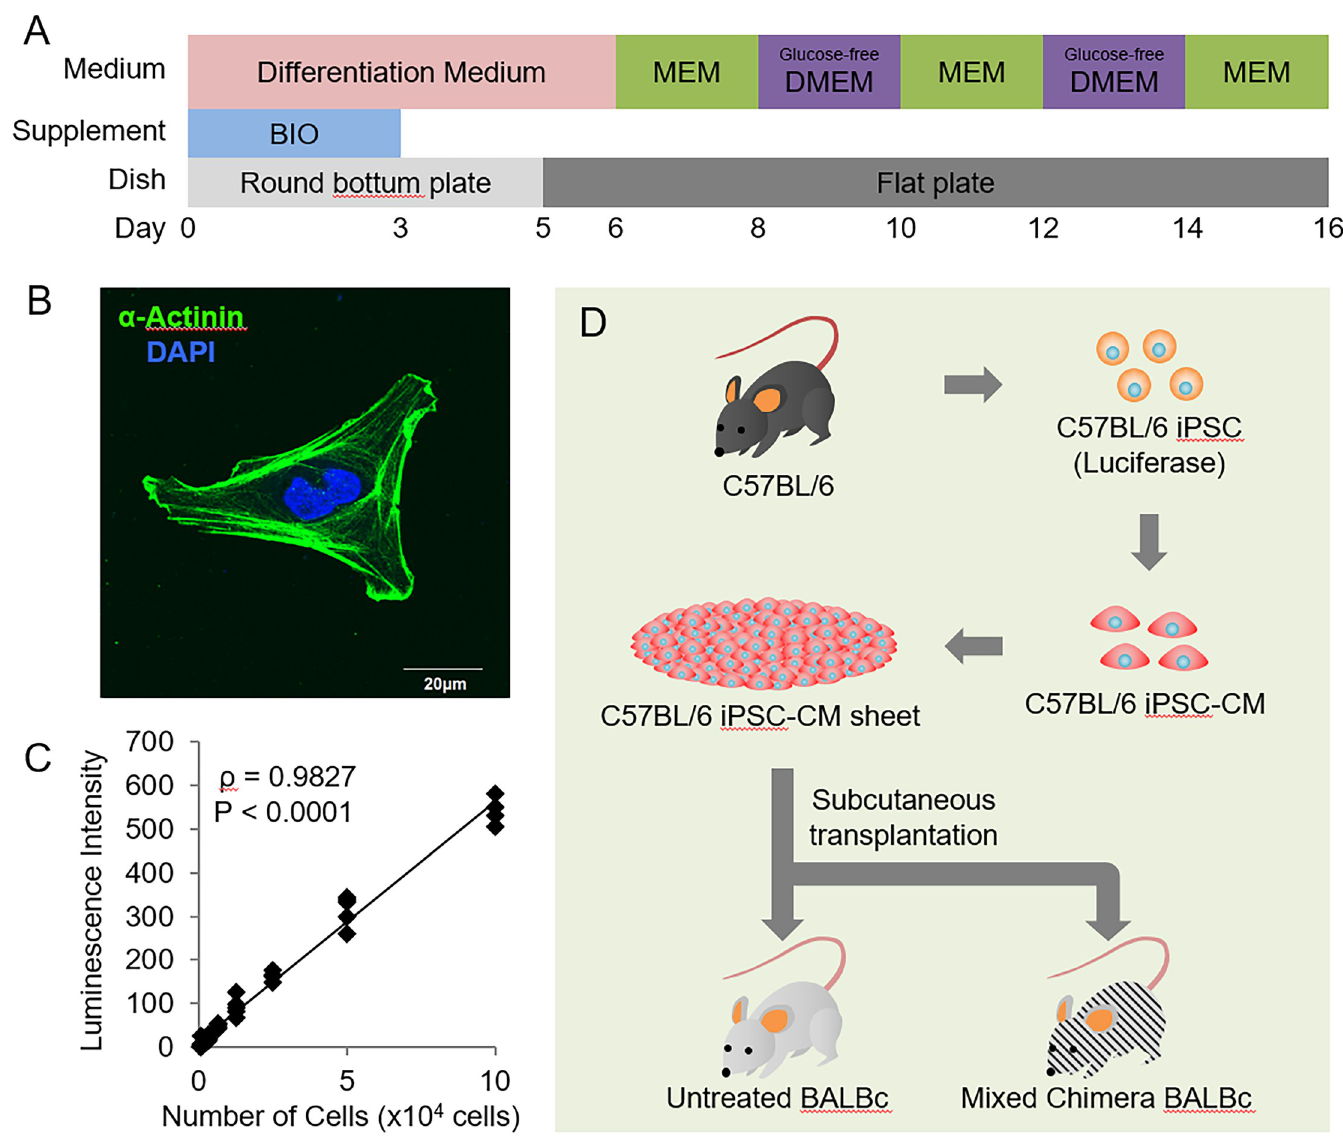
Fig 2. Experimental flow. (A) Cardiomyogenic differentiation protocol. (B) Immunocytochemistry for alpha-actinin (green) and DAPI (blue) in induced pluripotent stem cell (iPSC)-derived cardiomyocytes (iPSC-CMs). Scale bar, 20 μ m. (C) Positive correlation between the number of iPSC-CMs and bioluminescence ( ρ = 0.9827, P < 0.0001). (D) Transplantation scheme of luciferase-expressing murine iPSC-CM sheets derived from C57BL/6 mice into untreated normal BALB/c or mixed-chimera BALB/c